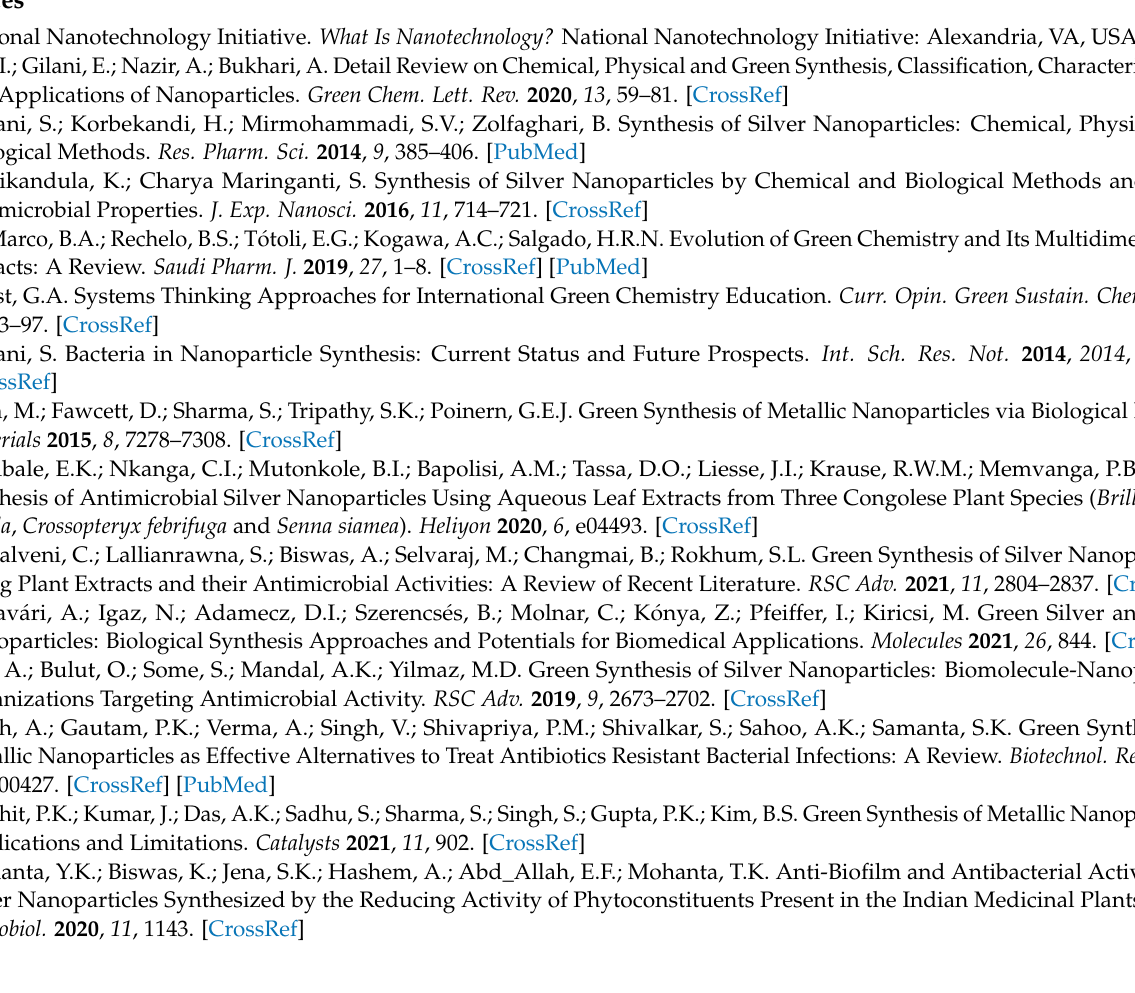
activities; Table S3. Antimicrobial green synthesized zinc (oxide) nanoparticles; Table S4. Green platinum nanoparticles exhibiting antimicrobial activity; Table S5. Green palladium nanoparticles with antimicrobial activity; Table S6. Green copper nanoparticles exhibiting antimicrobial activity; Table S7. Antimicrobial green-synthesized iron nanoparticles